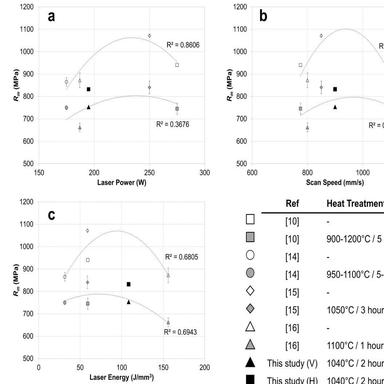
LPBF DSS 2205 ultimate tensile strength against key process parameters (a) laser power (b) scan speed and (c) laser energy. Including data obtained from this study and available literature 14–.